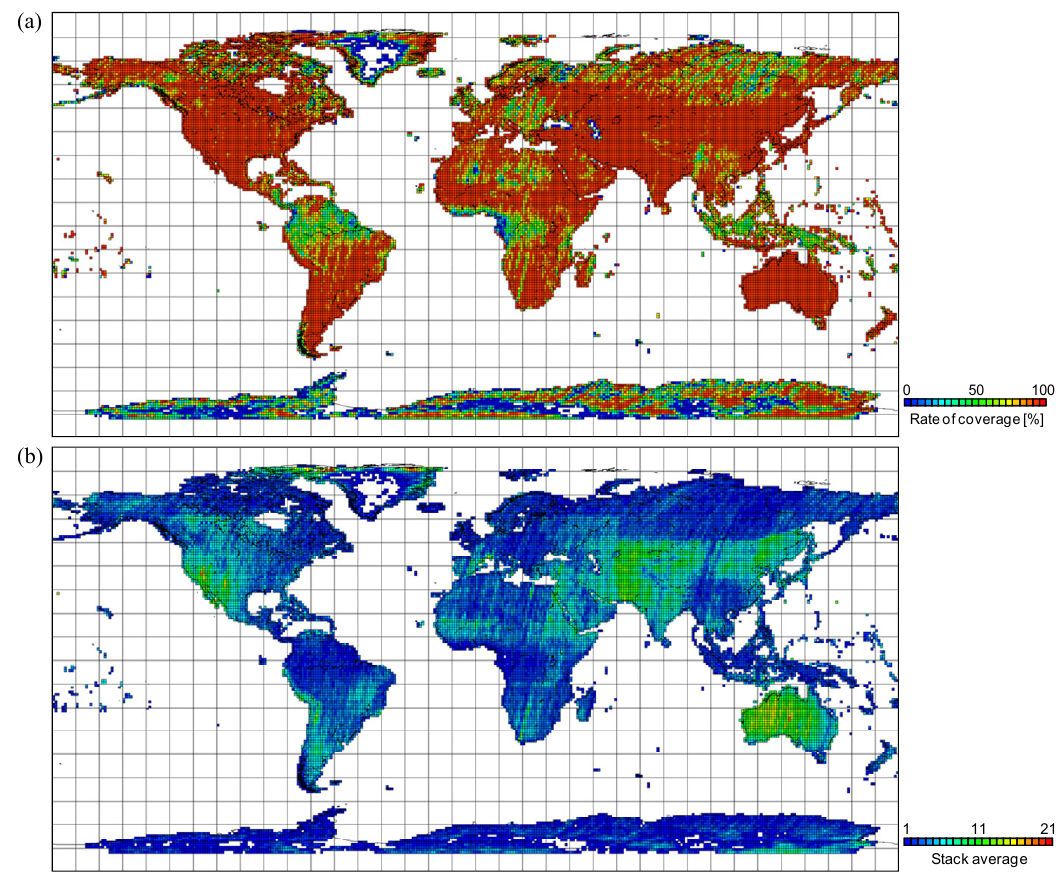
Figure 2. Distribution of coverage rates R (a) and stack averages S (b) for DSM-tiles. Table 1.Total values of R and S for tiles in latitude-zones of 20 degree intervals, as well as in whole areas, except for Greenland and Antarctica. Lat.